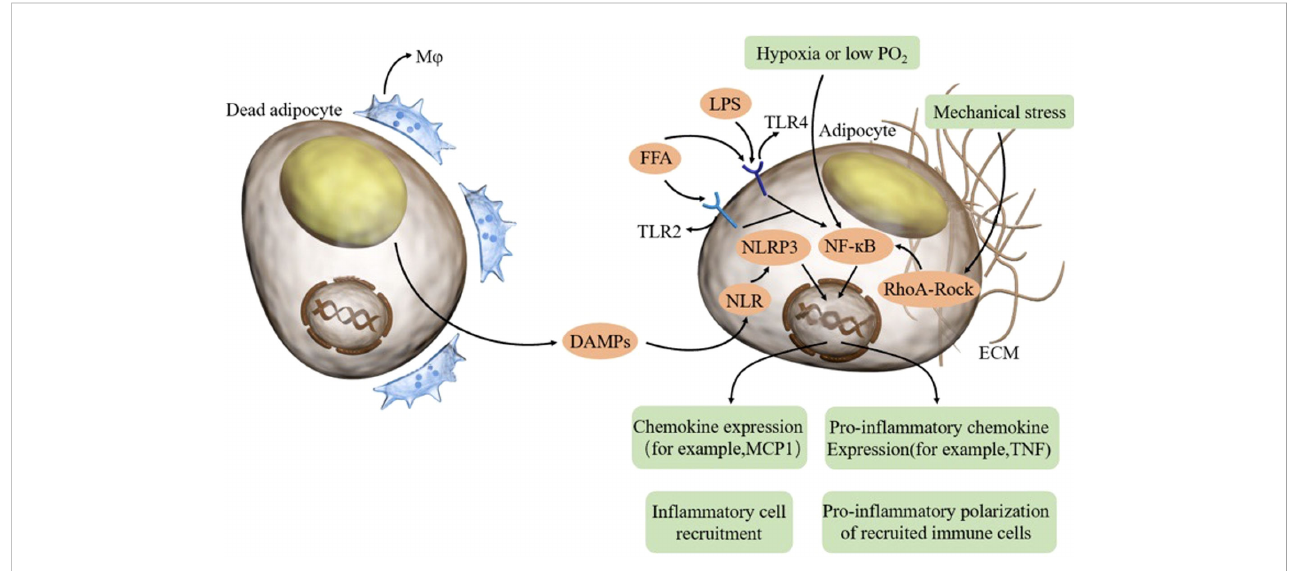
FIGURE 1 In aging adipose tissue, dead adipocytes induce macrophages and DAMPs, thereby activating the NLRP3 in fl ammasome in adipocytes. FFA and LPS combine TLR on adipocytes and activate NF k B. Hypoxia and mechanical stress can also activate NF k B. Adipocytes can produce proin fl ammatory cytokines and chemokines, thus recruiting in fl ammatory cells and promoting the proin fl ammatory polarization of recruited immune cells. FFA free fatty acid, LPS lipopolysaccharide, TLR toll-like receptor, DAMP damage-associated molecular patterns, NLR NOD-like